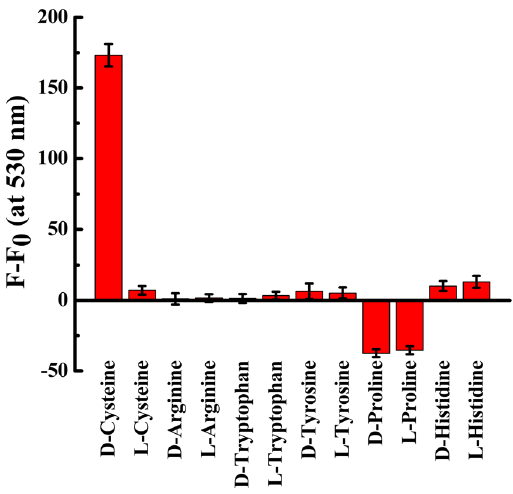
Figure 7. The responses of QDs to enantiomerically pure cysteine, arginine, tryptophan, tyrosine, proline and histidine amino acids at a concentration of 1 mmol L − 1 (in the presence of 60 mmol L − 1